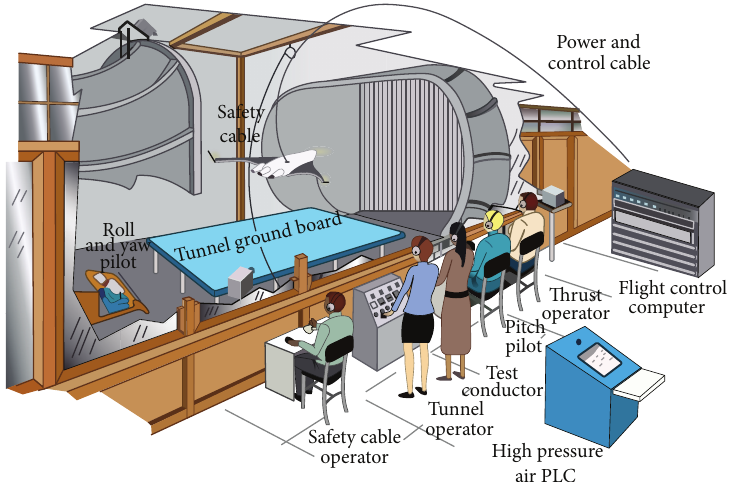
Figure 8: Low speed free-flight test setup with power system in the LFST [7].